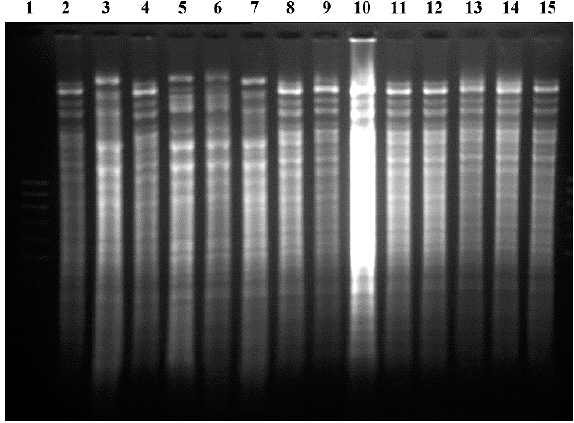
Figure 4. Restriction analyses of mitochondrial DNA of S. cerevisiae for CLQCA-10-099 (2), CLQCA-INT-001 (3), CLQCA-INT-005 (4) and UCLM 325 (5) strains. 1 kb DNA ladder (1). Strains present in the last fermentation cycle